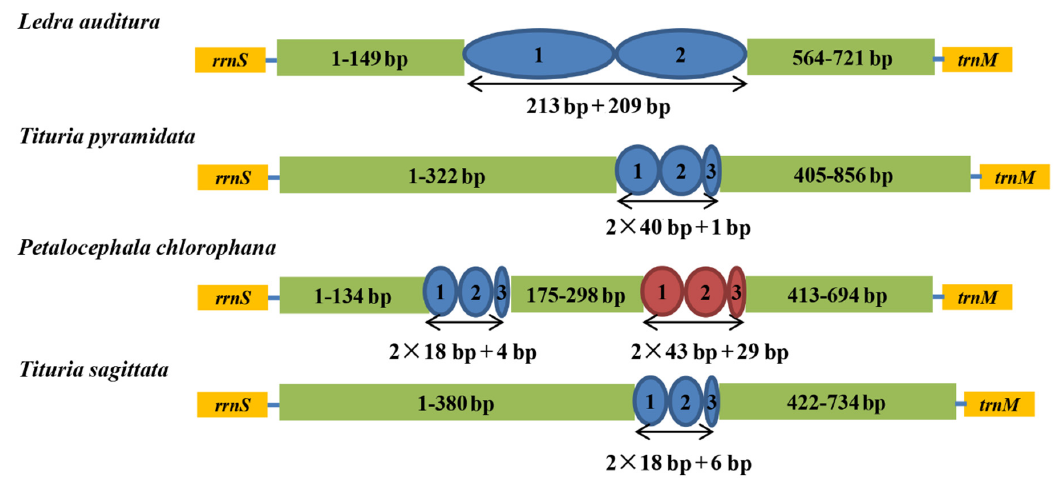
Figure 5. Organization of the control region in Ledrinae mtgenomes. The blue and red ovals indicate the tandem repeats; the non-repeat regions are shown with green boxes.